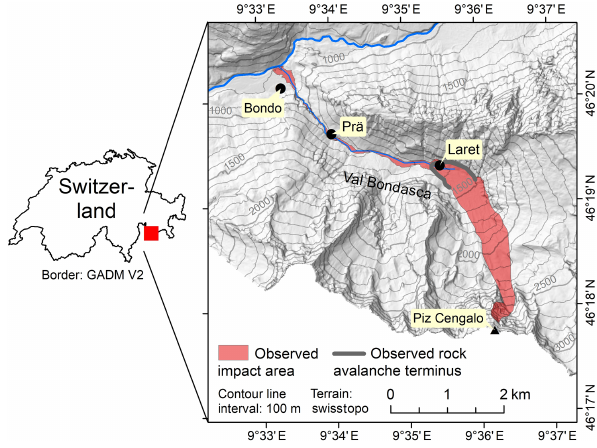
Figure 1. Study area with the impact area of the 2017 Piz Cengalo– Bondo landslide cascade. The observed rock avalanche terminus was derived from WSL